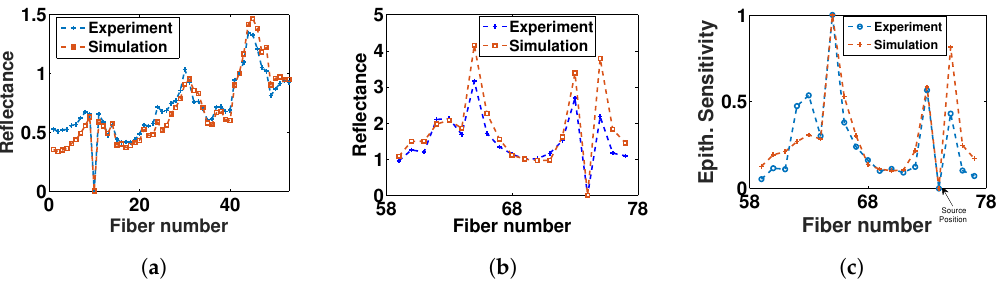
Figure 7. Comparison of simulated data and experimental data ( a ) for 53 outer ring fibers from 1 to 58 (measurement was not taken for fibers 24, 25, 26, 40 and 46) and ( b ) for all fibers of inner ring from 59 to 77, and ( c ) epithelial sensitivity measurement for inner ring